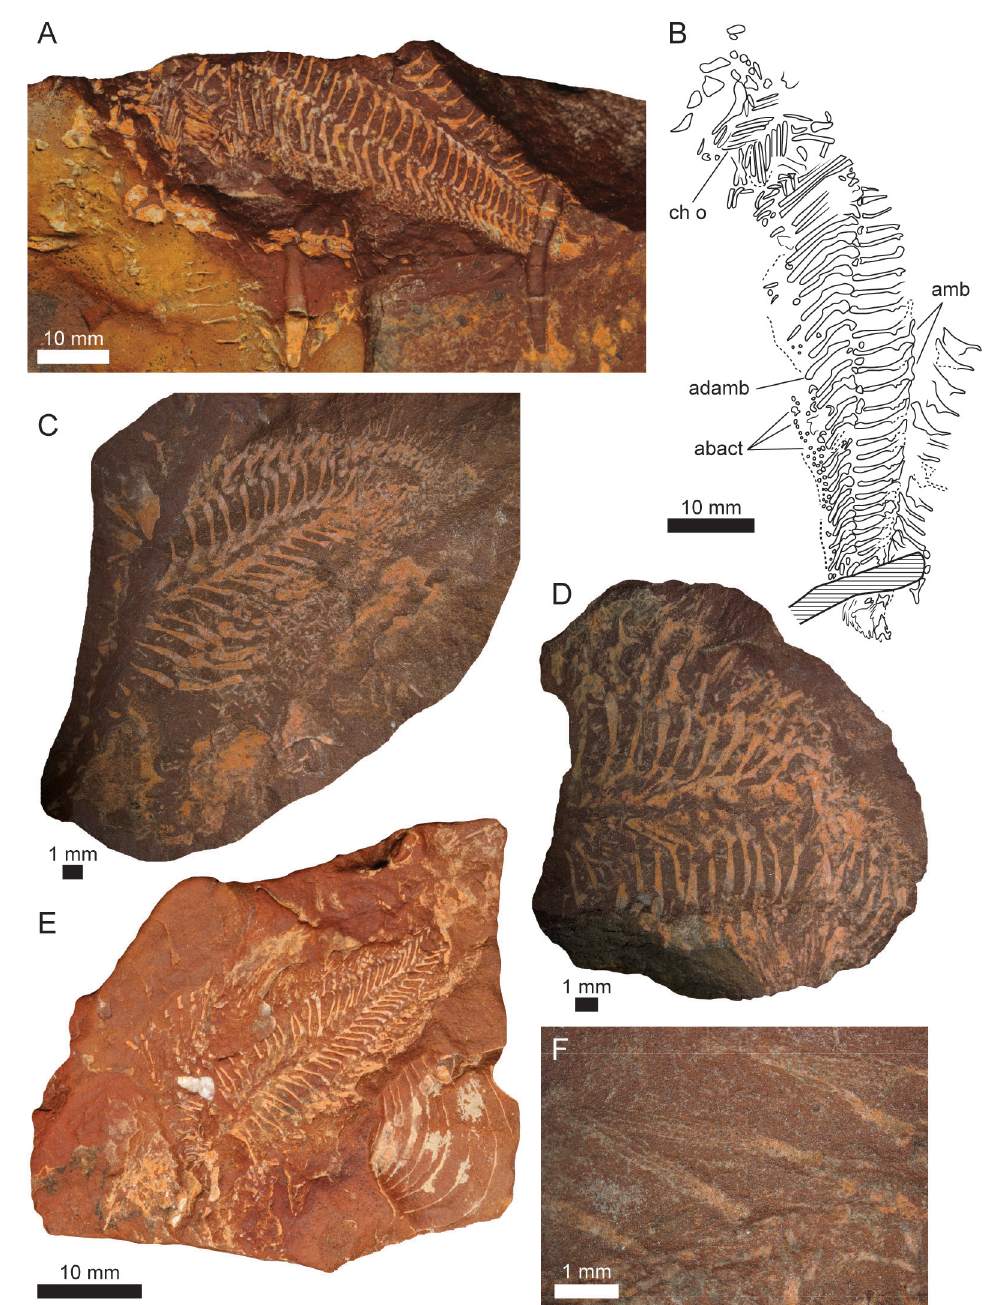
Fig. 3. Savignaster septentrionalis Rousseau & Gale sp. nov. A–B . Holotype PMO 218.000 . A . Complete arm and associated interradial area showing chevron ossicles. B . Drawing of holotype showing main morphological features. C . Paratype PMO 217.976, partial arm preserved up to the tip. D . Paratype PMO 217.977, partial arm specimen with elongated, narrow ambulacrals set at nearly right-angle to the arm axis. E . Paratype PMO 217.978, a near complete arm with associated adambulacral spines. F . Paratype PMO 218.008, close-up view of fan-shaped trellis-like adambulacral spines articulated to the lateral margin of the adambulacral. Abbreviations: abact = abactinal ossicle; adamb = adambulacral; amb = ambulacral; cho =